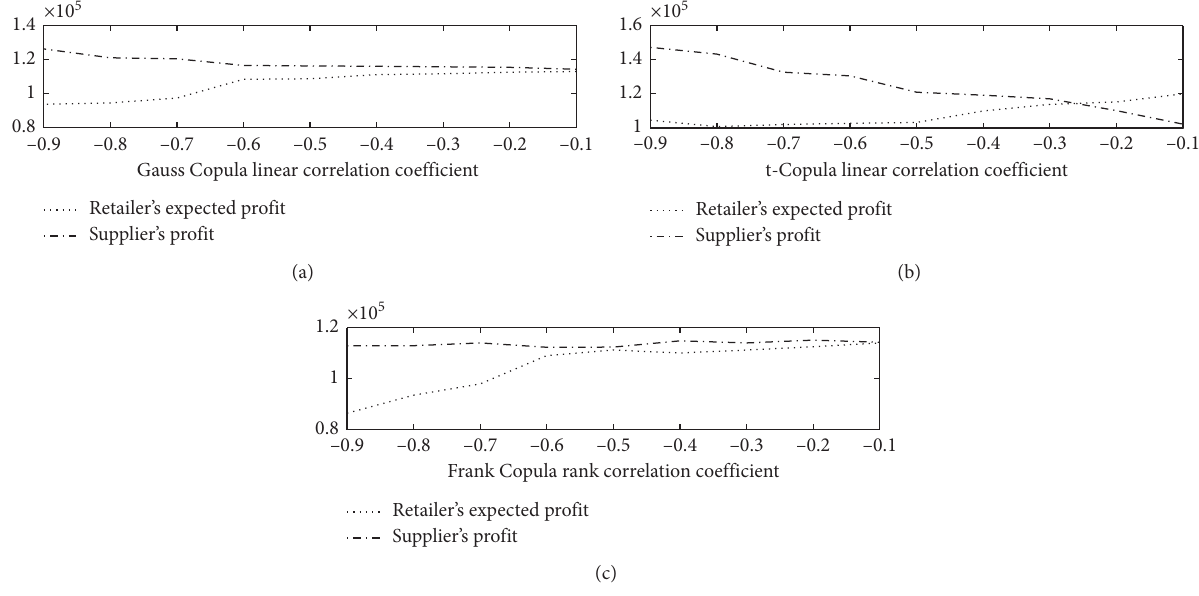
Figure 6: The impact of correlation on each profit in different Copula markets.